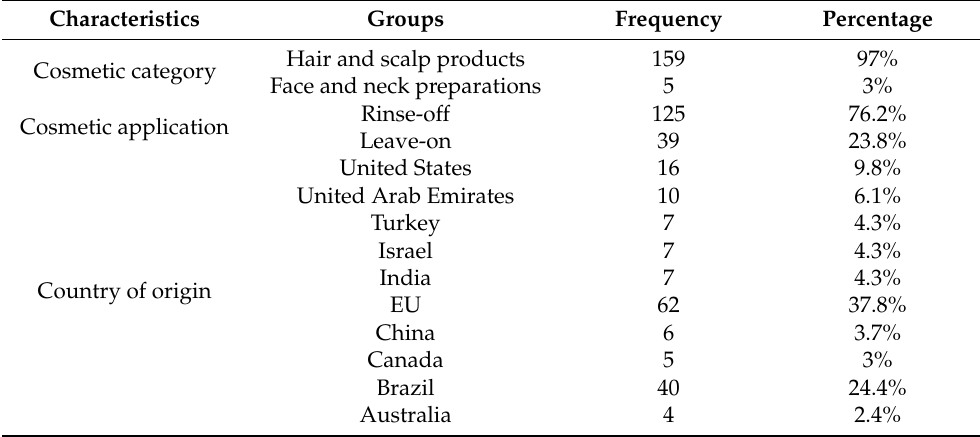
Table 1. Number and percentages of sample baseline characteristics ( n = 164).